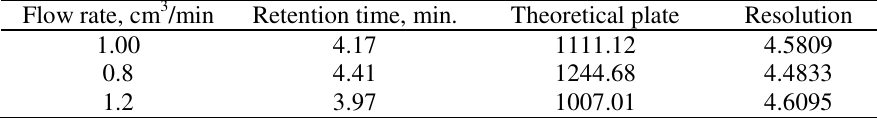
Table 3. Effect of flow rate - paracetamol